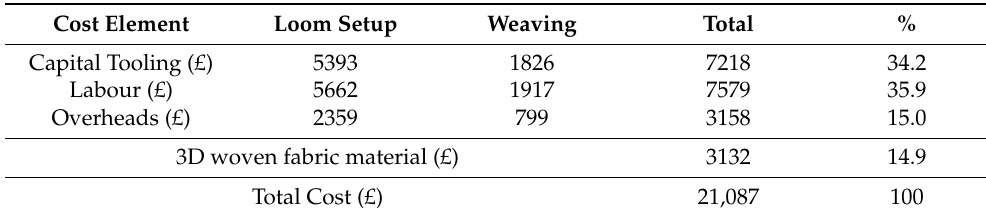
Table 8. Estimated cost of 3D woven fabric, eight Jacquard preforms.